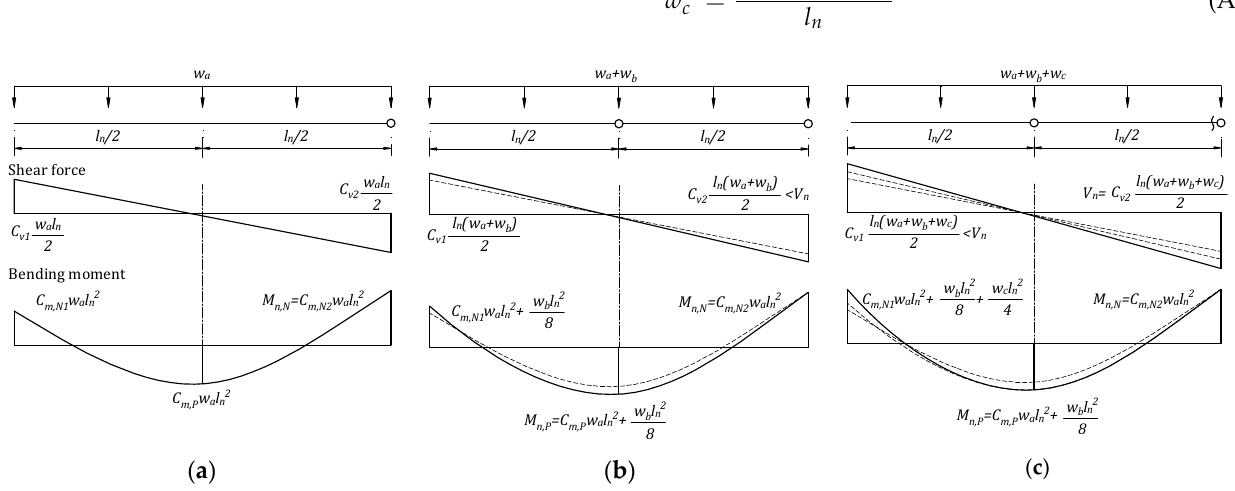
Figure A4. Failure mechanism for DB-2 region. ( a ) Flexural failure at the N2 section first; next, ( b ) flexural failure at the mid-span section; and finally, ( c ) shear failure at the N2